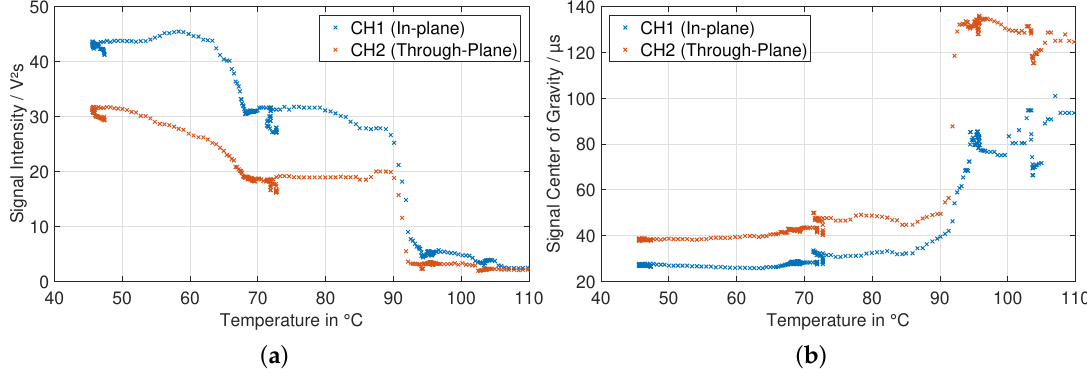
Figure 17. Signal intensity (left, ( a )) and signal center of gravity (right, ( b )) over temperature during the heat-up period of the